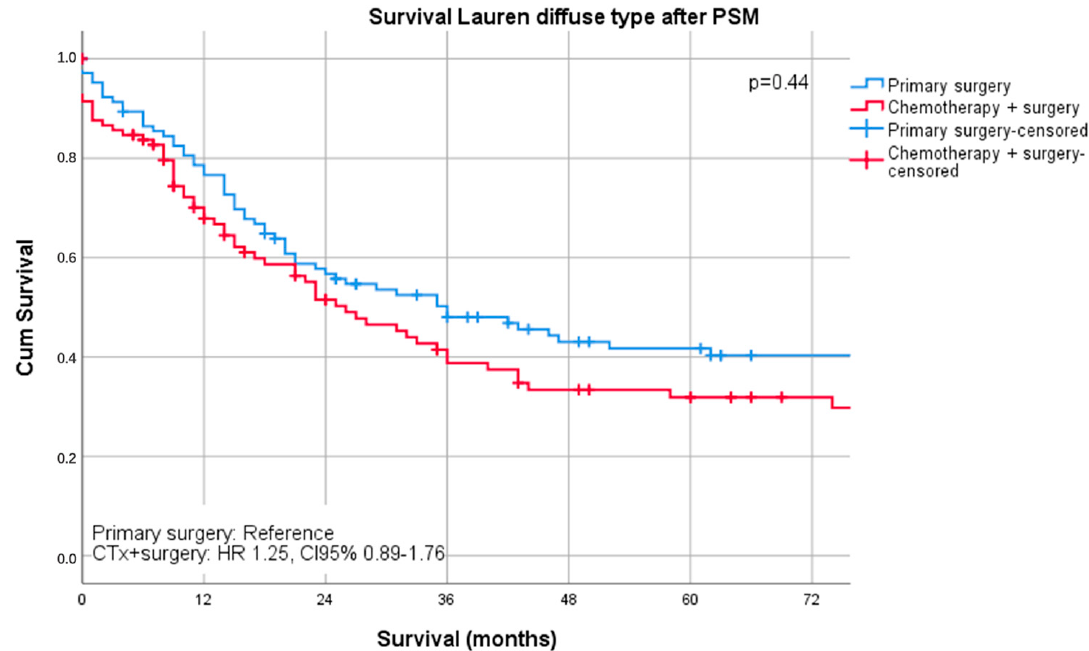
Figure 3. Survival curves for Lauren diffuse subtype after PSM stratified by surgery only vs. chemotherapy plus surgery.